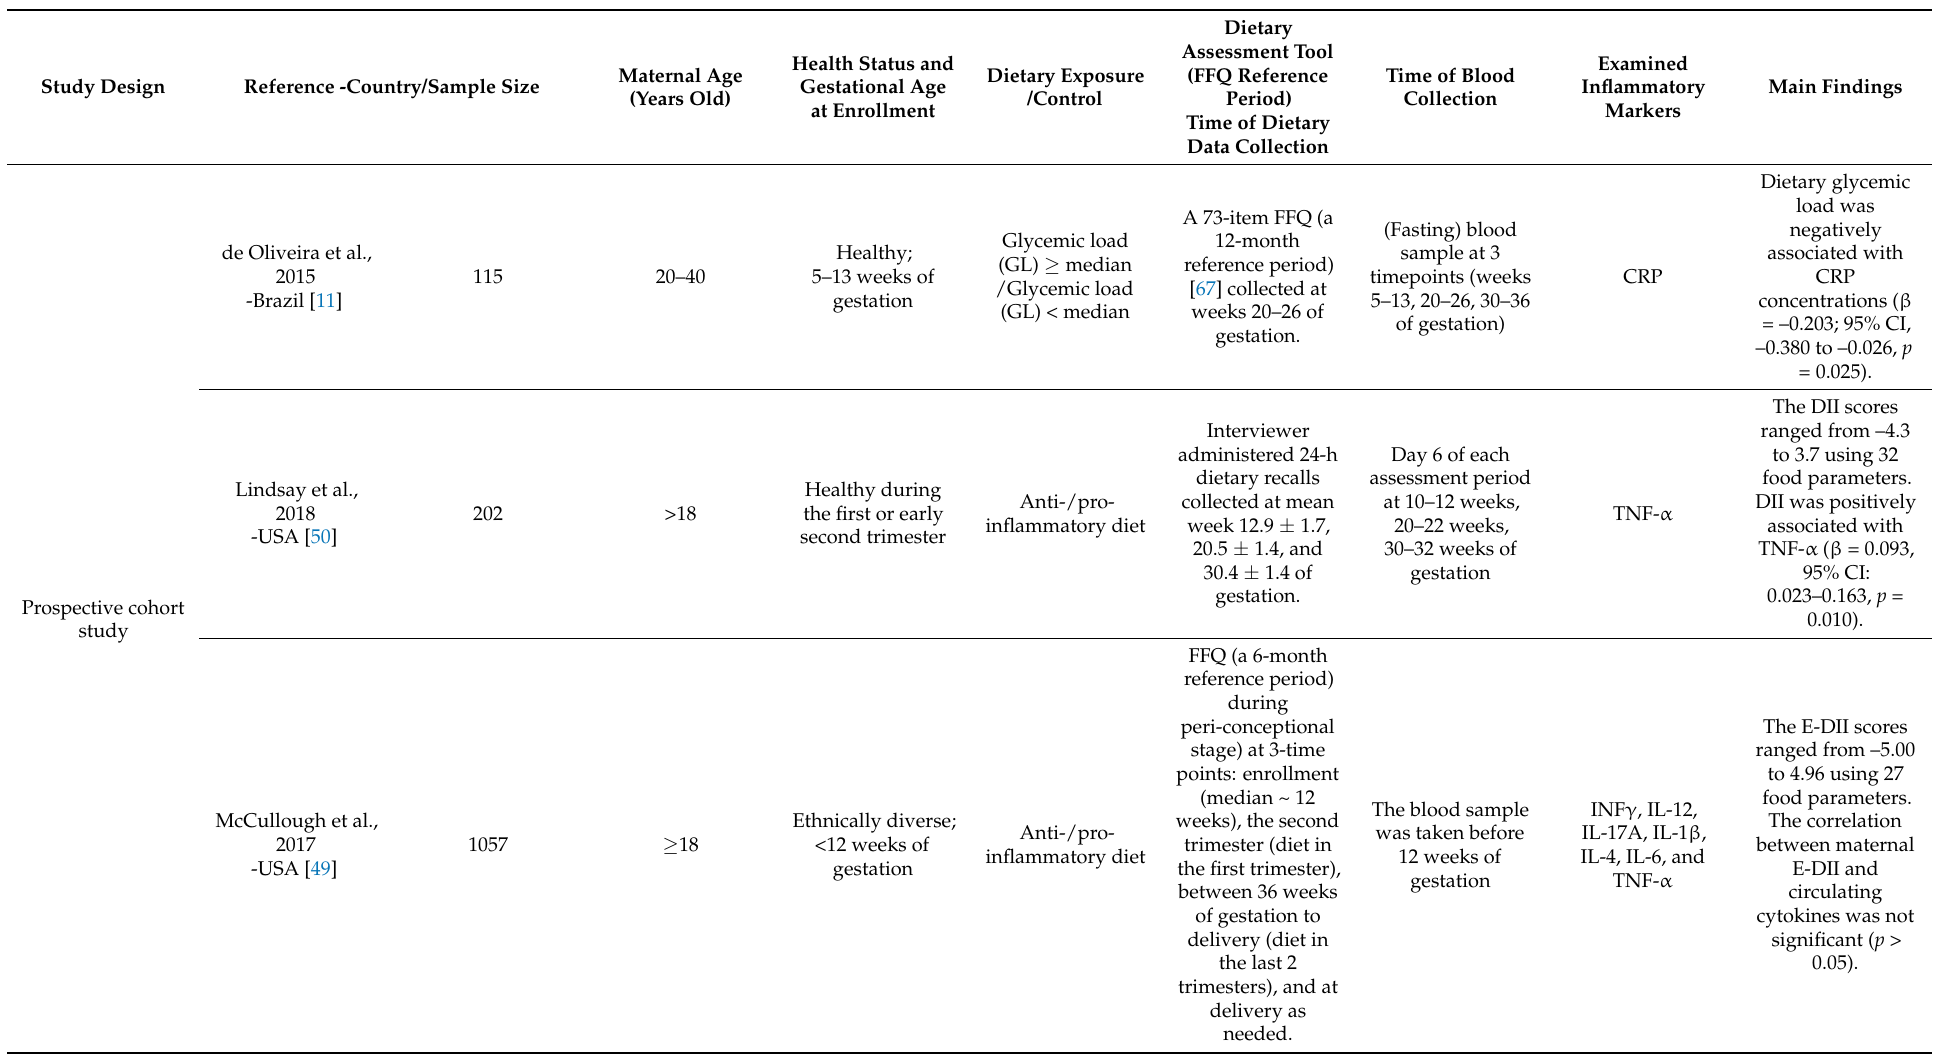
Table 1. Characteristics of the studies examining the relationship between diet and inflammatory